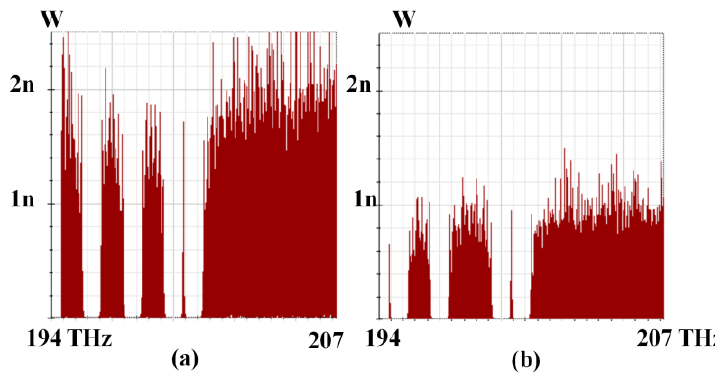
Figure 3. Downlink transmitted spectrum for user in ( a ) Class 2 and ( b ) Class 1.